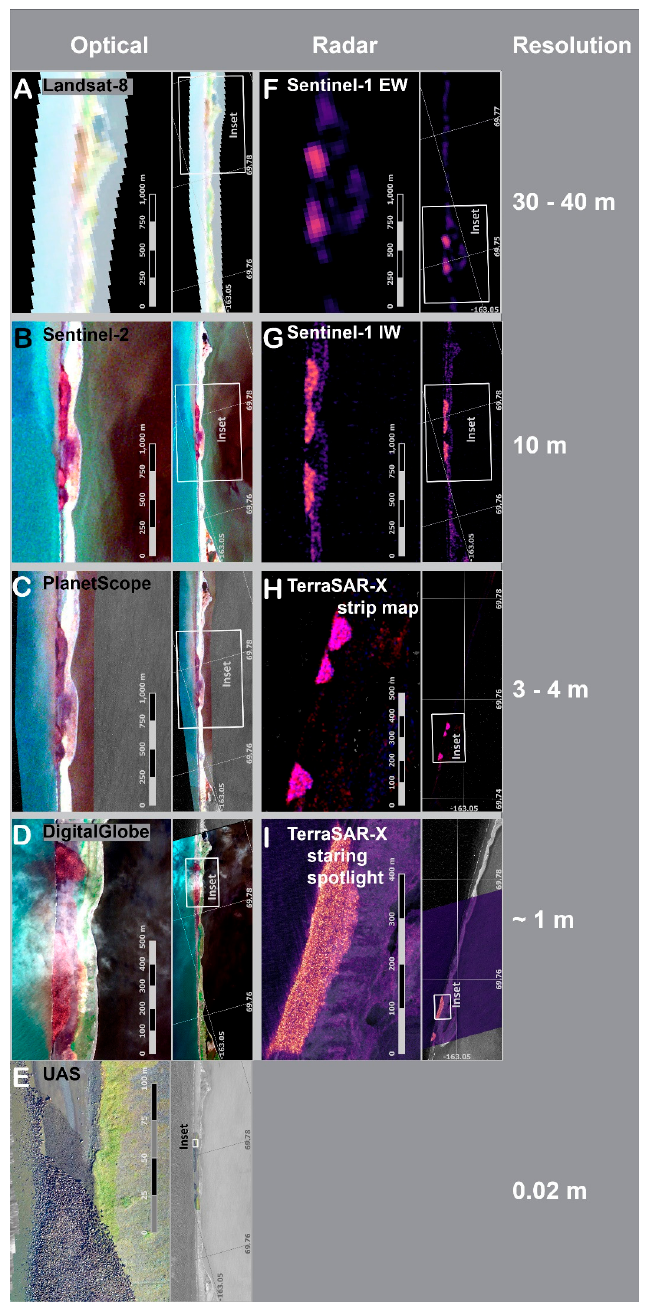
Figure 1. Examples of the imagery types evaluated in this study for detecting Pacific walrus haulout aggregations on the beach near Point Lay Alaska. Each panel is labeled with the name of the